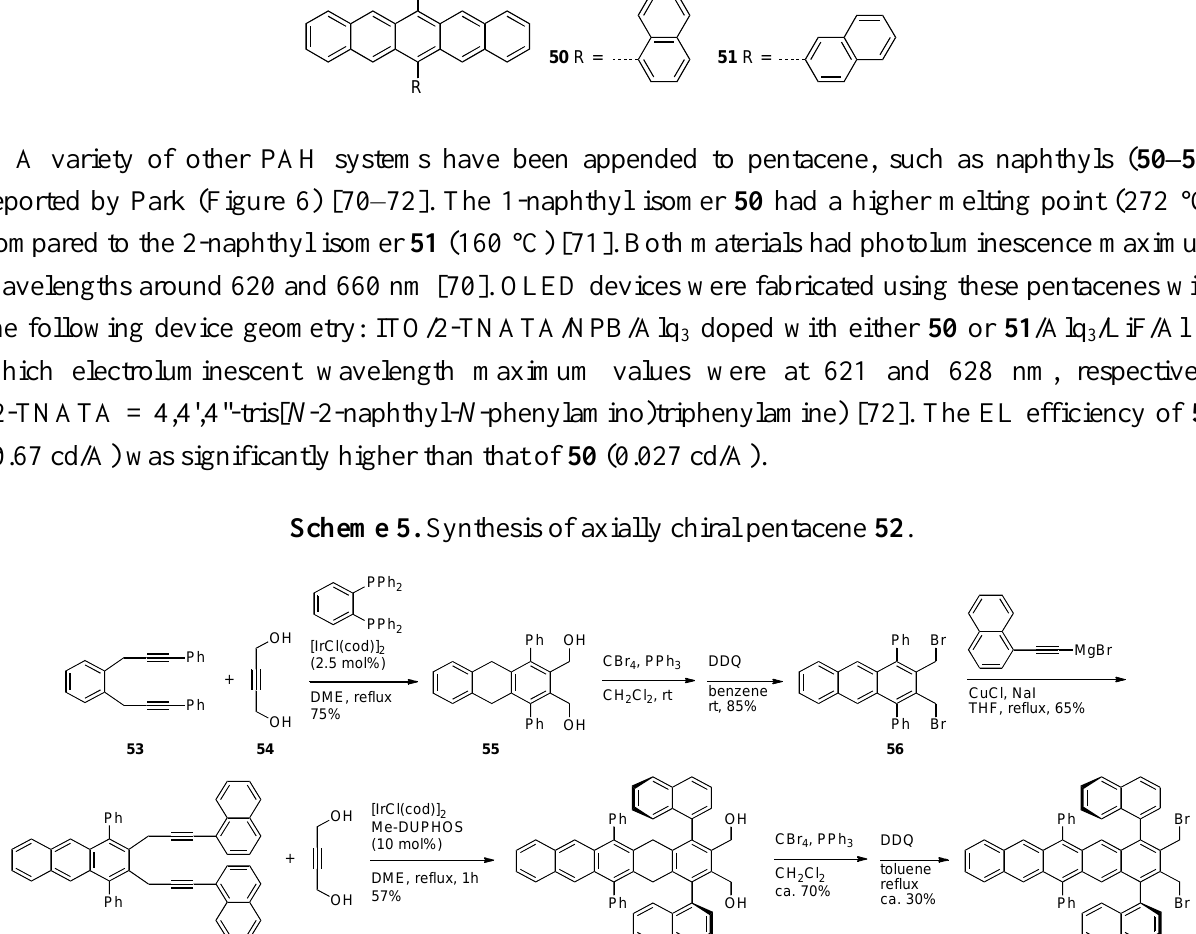
Figure 6. Structures of 6,13-bis(naphthyl)pentacenes 50–51 . R 50 R = 51 R = R